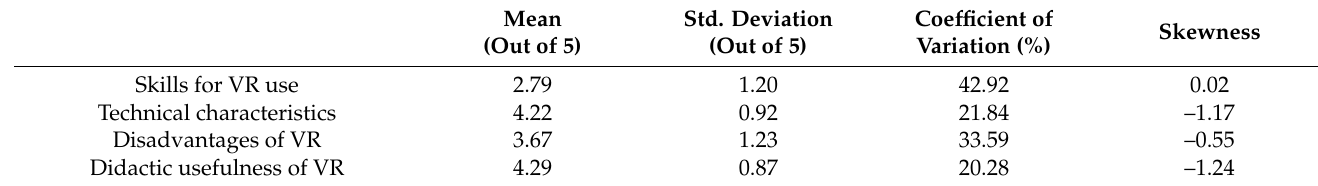
Table 2. Descriptive statistics of the responses to the different families of questions.